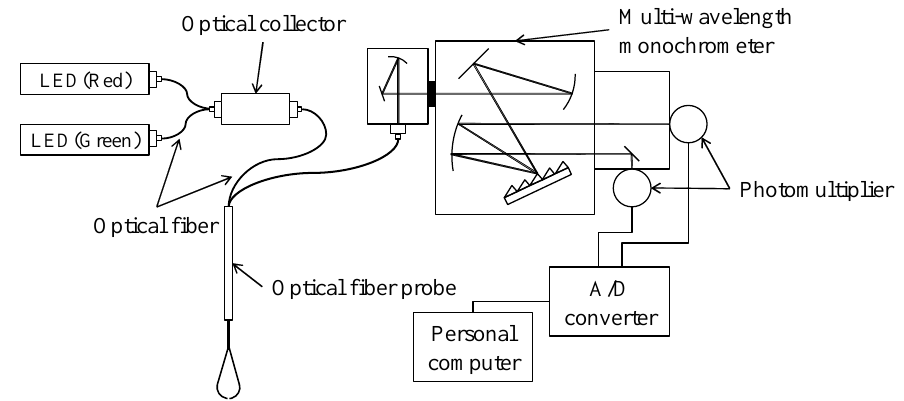
Fig. 5 Schematic of the concentration measurement system. Two LEDs are equipped as light sources.